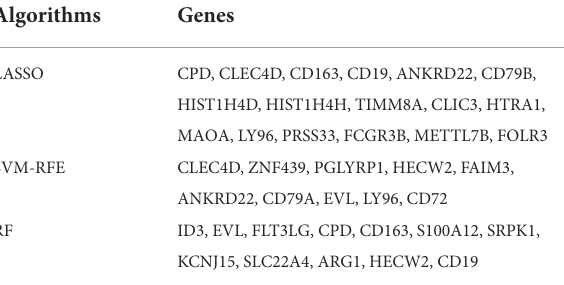
TABLE 2 Feature genes screened by machine learning